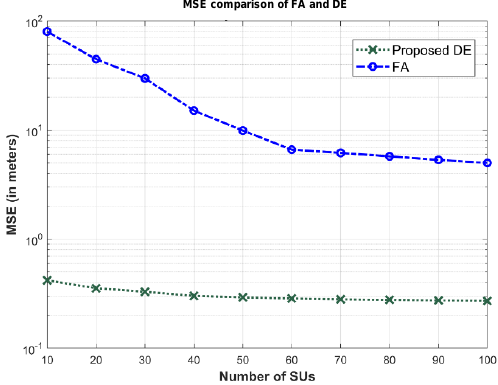
Figure 7. The deviation in MSE with the variation in the number of SUs.